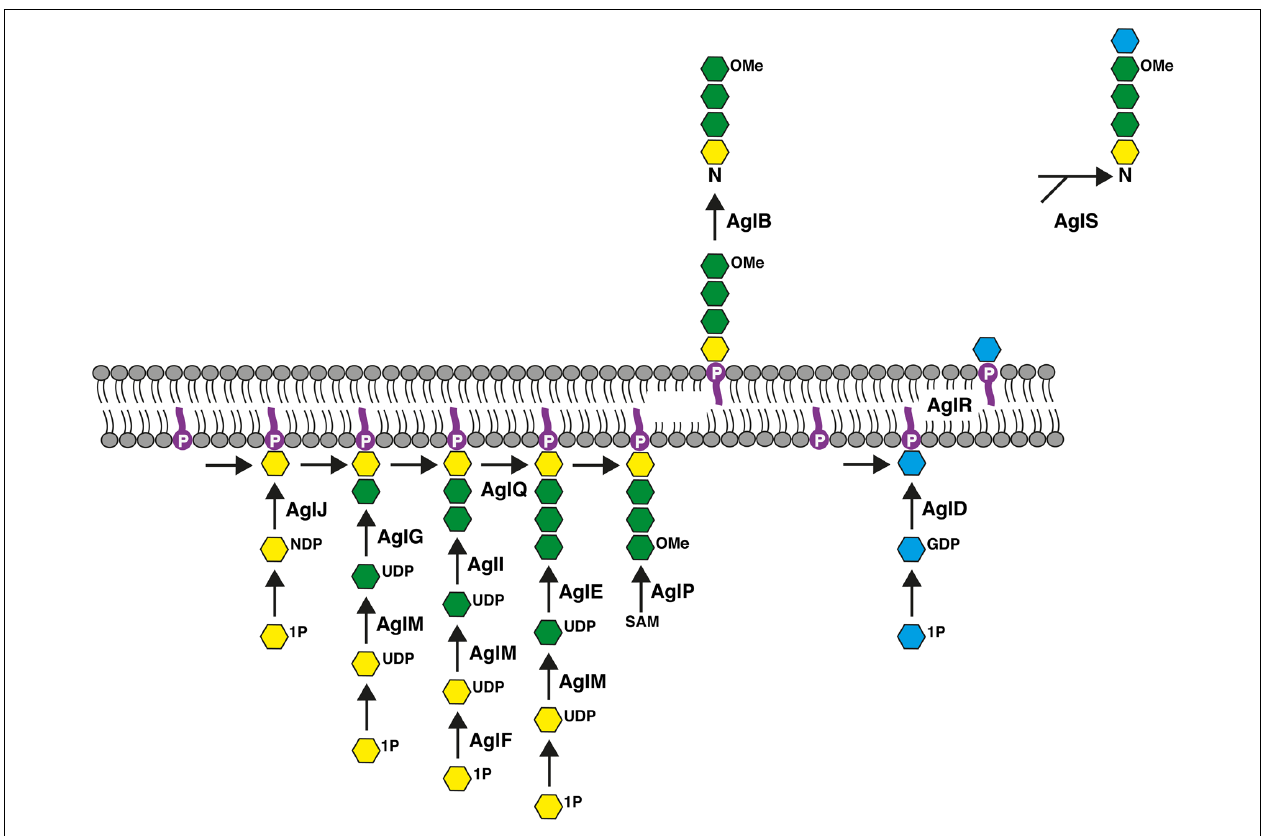
FIGURE 1 | Schematic depiction of the Hfx. volcanii Agl pathway used for the assembly and attachment of the pentasaccharide N-linked to the S-layer glycoproteinAsn-13 andAsn-83 positions. See the text for details.